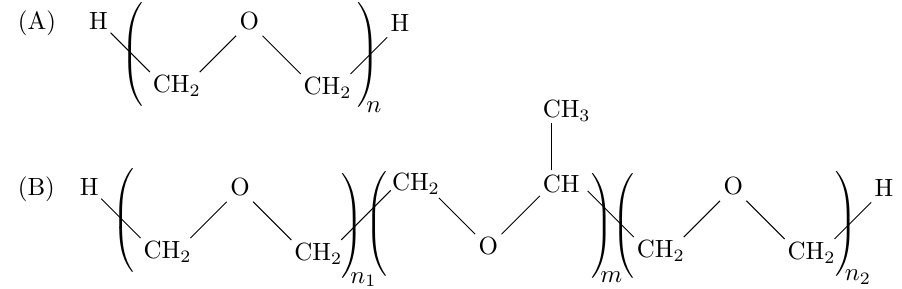
Figure 1. Structures of PEO ( A ) and the PEO-PPO-PEO ( B ) triblock